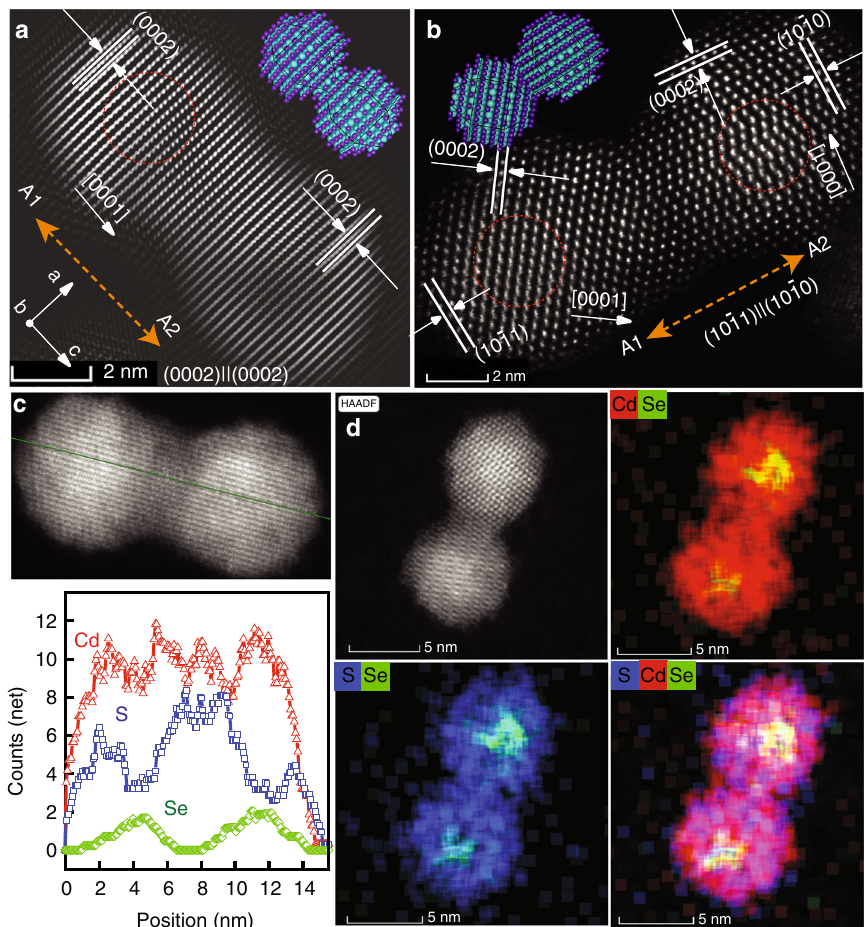
Fig. 4 Characterization of 1.4/2.1 nm CQDs molecule. Fourier- fi ltered HAADF-STEM images of the coupled CdSe/CdS molecules with homo-plane attachment of (0002)||(0002) ( a ) and hetero-plane attachment of (10 (cid:1) 10)||(10 (cid:1) 11) faces ( b ). c EDS line scan data and d STEM-EDS